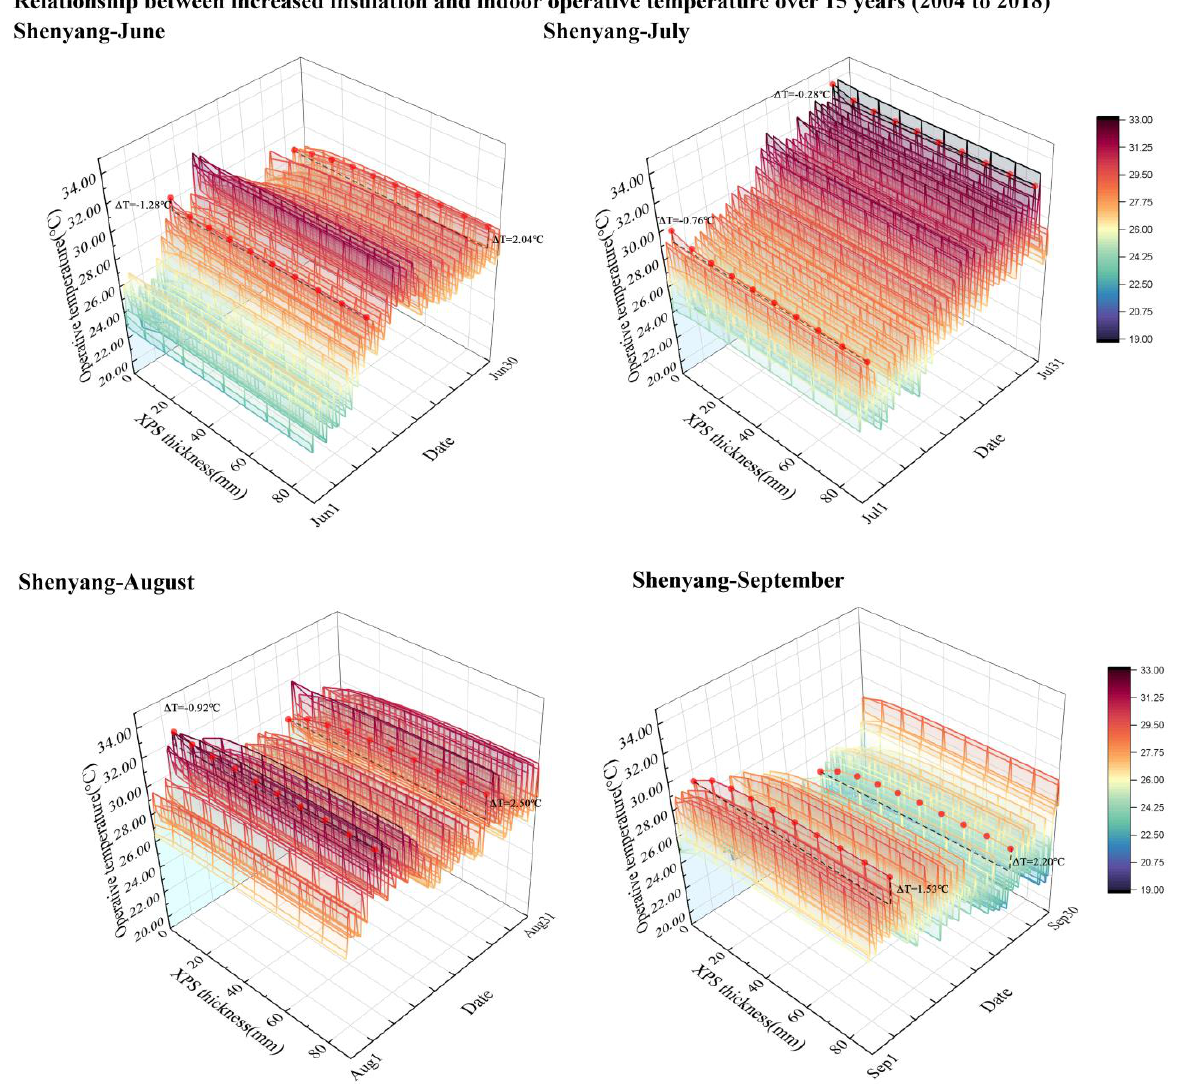
Figure 10. Relationship between increased insulation and indoor operative temperature (divided into various temperature bands) in the south-facing bedroom in Shenyang ( Ⅰ C sub-region). into various temperature bands) in the south-facing bedroom in Shenyang (IC